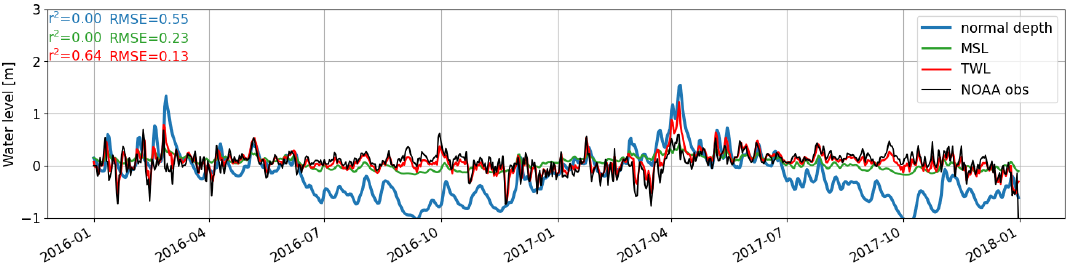
Figure 6. Comparison of daily-averaged simulated and observed water level at NOAA gauge 8546252.